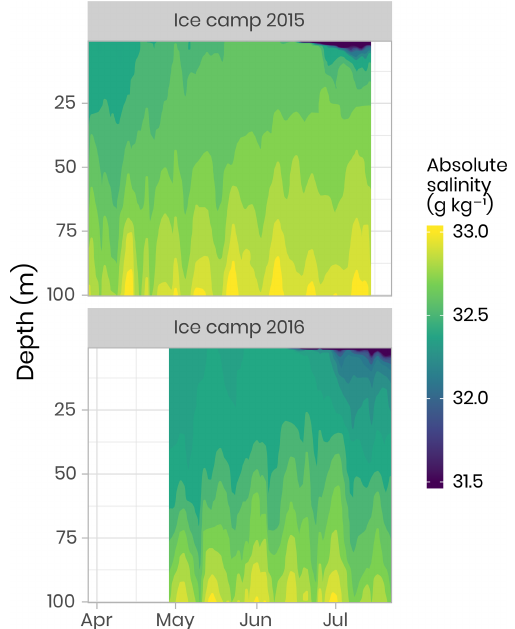
Figure 3. Temporal evolution of the salinity in the first 100m of the water column for both campaigns. Note that, for visualization pur- poses, salinity below 31.5gkg − 1 has been binned to 31.5gkg − 1 . Note that salinity as low as 4gkg − 1 was observed during flushes of freshwater at the ocean surface due to snow and ice melt (dark blue color in the